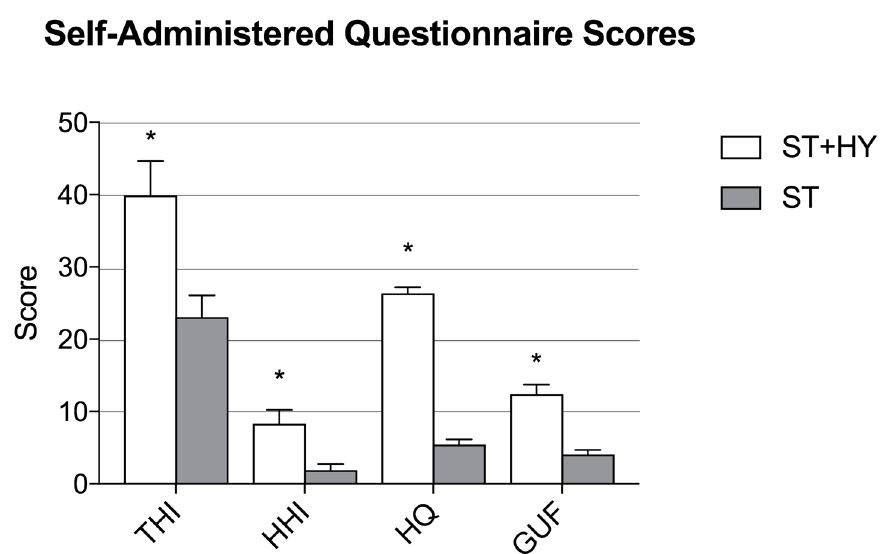
Fig 1. Self-administered questionnaire scores. Comparisonof Self-Administered Questionnaire scores for Tinnitus HandicapInventory (THI), HearingHandicapInventory (HHI), the HyperacusisQuestionnaire (HQ) and the Gera¨uschu¨berempfindlichkeit(GUF) questionnaires betweenhyperacusis (ST+HY) and non hyperacusis (ST) patients with somatic tinnitus. All questionnairescores were significantly higheramong ST +HY patients comparedto ST patients (p <